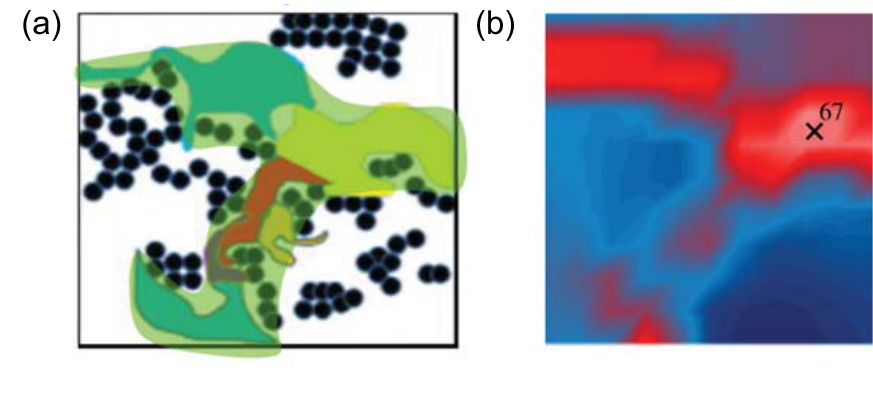
Figure 28. Strain amplification in filled elastomers under tension: ( a ) experimental and ( b ) computational results. The green/yellow and red colors in ( a ) and ( b ), respectively, correspond to high strain localization regions. Parts ( a ) and ( b ) reproduced with permission from [32,398],